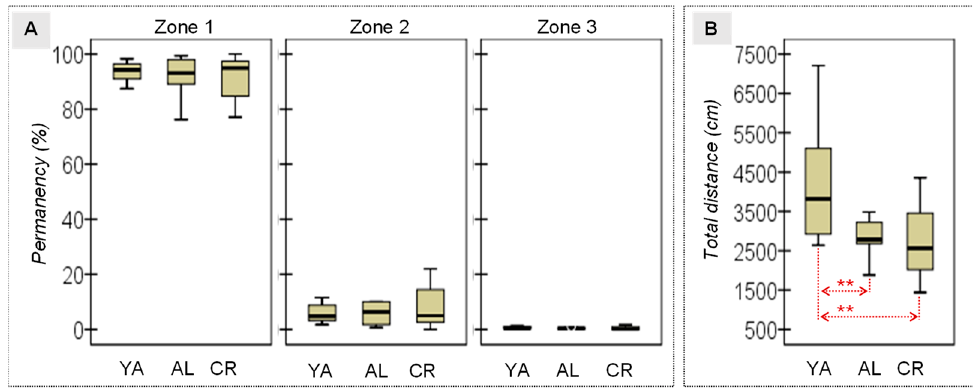
Figure 2. ( A ) Relative permanence in the three zones of the OF. ( B ) Locomotor activity (total distance travelled). YA, young adult; AL, ad libitum; CR, caloric restriction; ** Large–high effect size (| d | > 0.80).